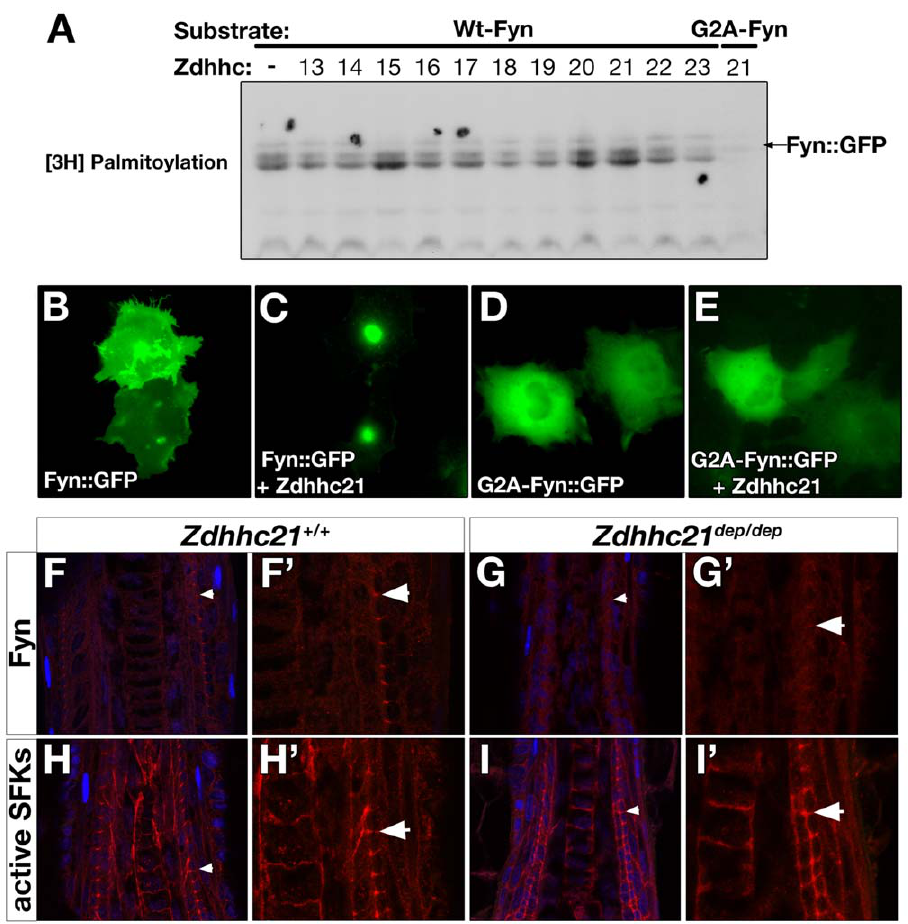
Figure 7. Zdhhc21 palmitoylation of Fyn is required for localization invitro and invivo . (A) [3H]Palmitate fluorography of subset of panel of all mammalian Zdhhc HA-tagged constructs co-transfected with Fyn::GFP into HEK293 cells. Increased incorporation of [3H]palmitate into targets is observed with Zdhhc15, 2 20 and 2 21. A myristoylation-deficient Fyn mutant is not palmitoylated following cotransfection with Zdhhc21 (G2A, final lane). (B–E) Immunofluorescence of HEK293 cotransfected with Fyn::GFP alone (B), Fyn::GFP and wild type HA-tagged Zdhhc21 cDNA (C), G2A mutant Fyn::GFP alone (D) and G2A mutant Fyn::GFP and HA-tagged Zdhhc21 (E). Zdhhc21 causes increased perinuclear accumulation of Fyn::GFP, a domain associated with localization of other palmitoylated targets including PSD-95 and GAP-43. This localization is not observed with G2A mutant Fyn::GFP (D). (F–I) Confocal images (0.5 m m) of immunostaining of Fyn (red: F,G) and active SFKs (red: H–I) in P32 anagen dorsal hair follicles in wild type (F,H) and dep mutants (G,I). Arrowheads mark region of interest in IRS cuticle that are enlarged in single channel images (F 9 –I 9 ) where Fyn localization to membranes between IRS cuticle cells is lost in dep mutants.